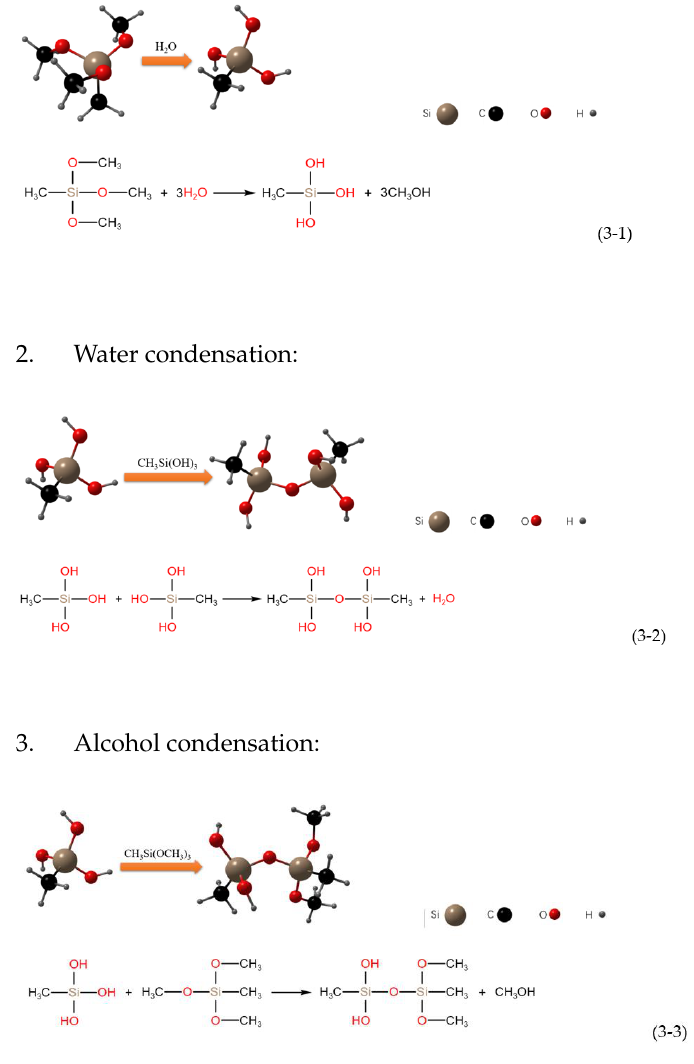
The three hydrolyzed methoxyl groups of the MTMS monomer are hydrolyzed and polymerized in a three-step reaction [51], as shown in the following